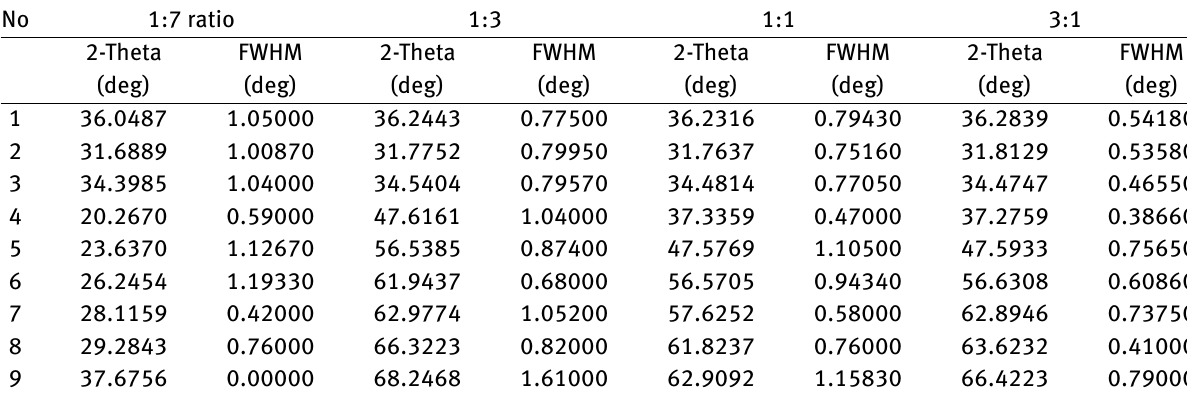
Table 2: XRD data of synthesized ZnO NPs with different ratios of precursors.